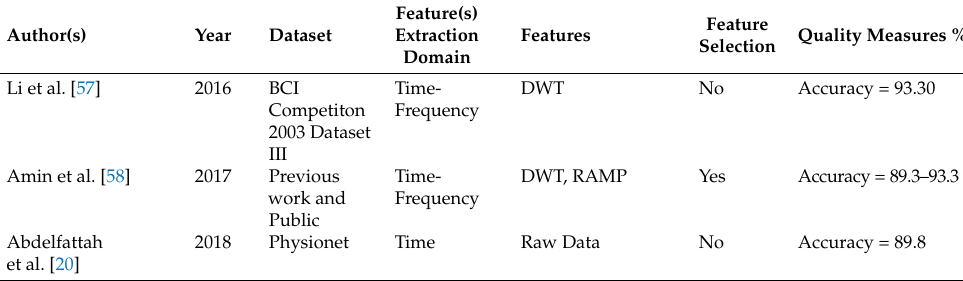
Table 2. Feature extraction and feature selection